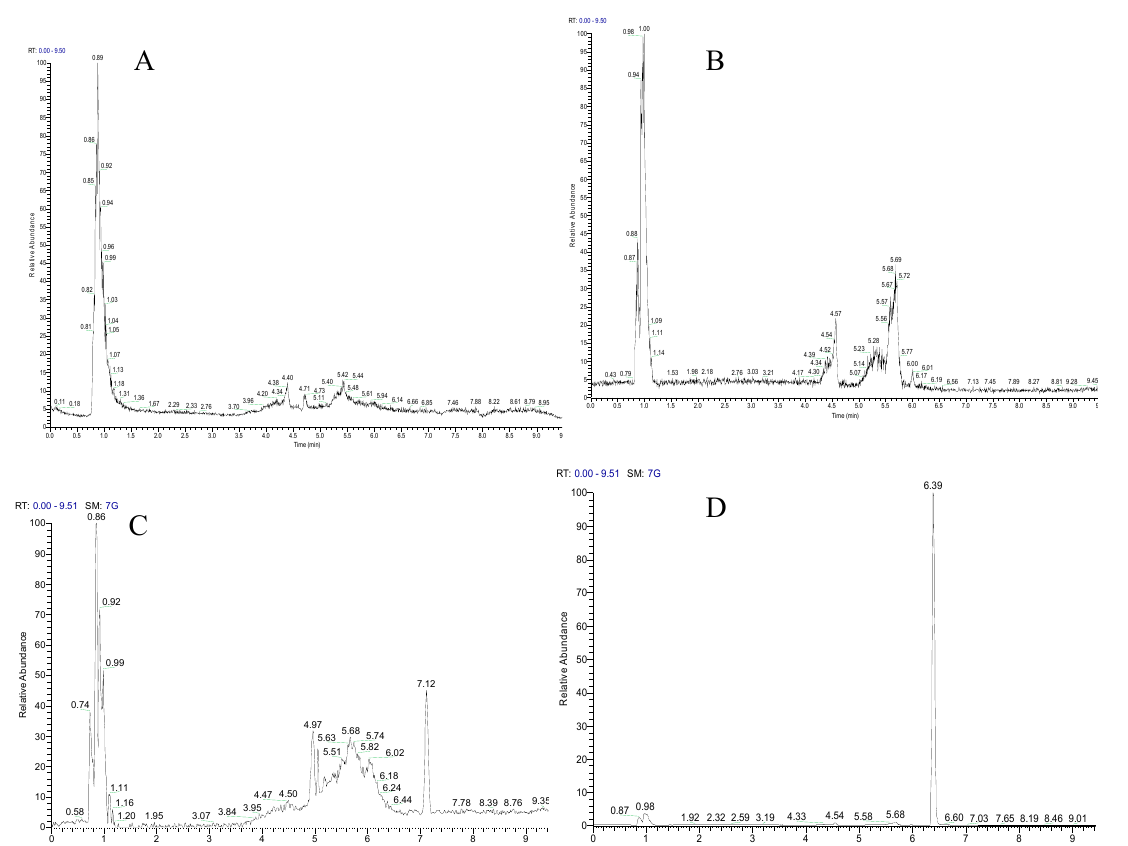
Figure 1. Base peak chromatograms of plasma, after protein precipitation and extraction, analyzed in negative ion mode; ( A ) blank plasma and ( C ) treated plasma, for the 302.5–303.5 mass range revealing no interference with tHGA at RT 7.1 min, ( B ) blank plasma and ( D ) treated plasma sample showing for the 204.5–205.5 mass range revealing no interference with the IS at RT at 6.3 min. Treated plasma was obtained from rat blood spiked with 0.5 ng/mL of tHGA.